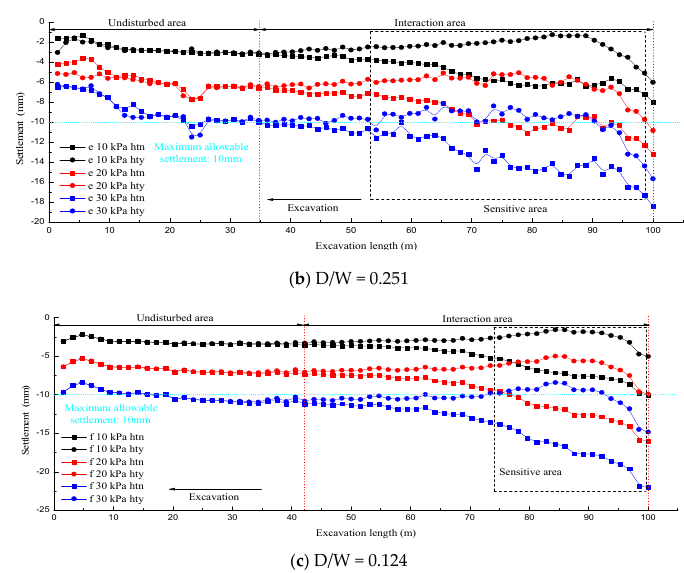
Figure 9. Longitudinal surface settlement of models D-D to F-F with C/H = 0.606.